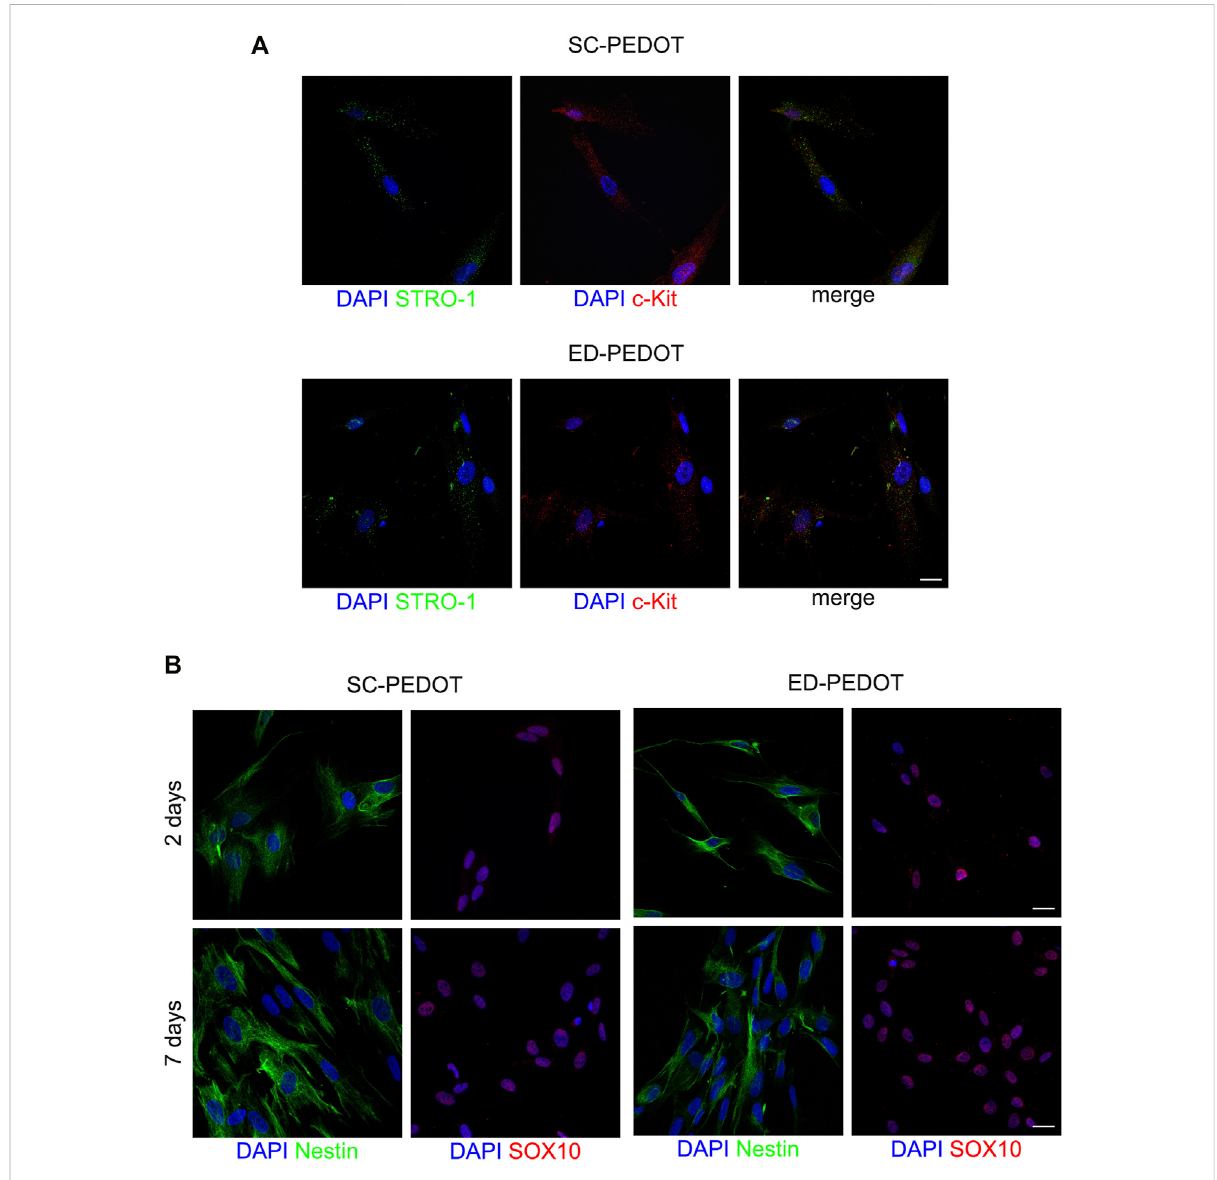
Evaluation of stemness and neural crest markers in hDPSCs cultured on PEDOT: PSS fi lms. (A) Immuno fl uorescence images show the expression of the stemness markers STRO-1 (green) and c-Kit (red) after 48 h of culture and (B) the neural crest related markers Nestin (green) and SOX10 (red) in hDPSCs after 48 h and 7 days of culture on both types of PEDOT:PSS fi lms. Nuclei were counterstained with DAPI. Scale bar: 10 μ m (A) , 20 μ m (B)